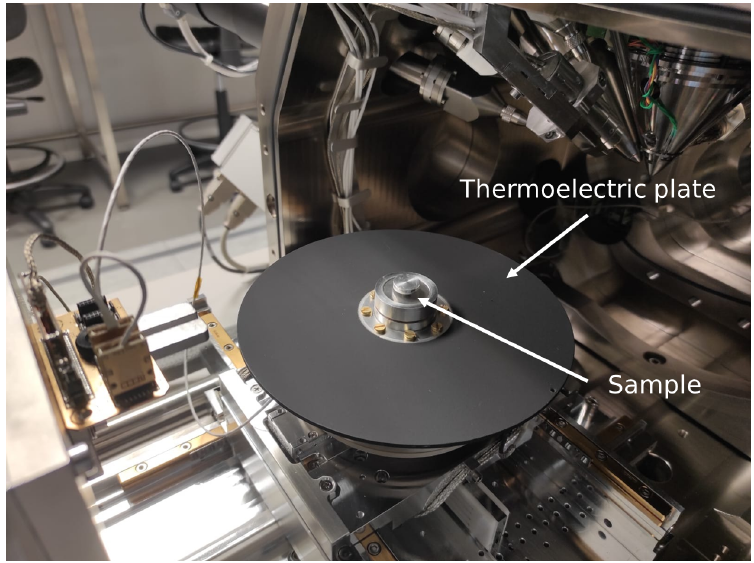
Figure 1. Open chamber of the Helios 650 NanoLab FIB/SEM microscope with the MHCS